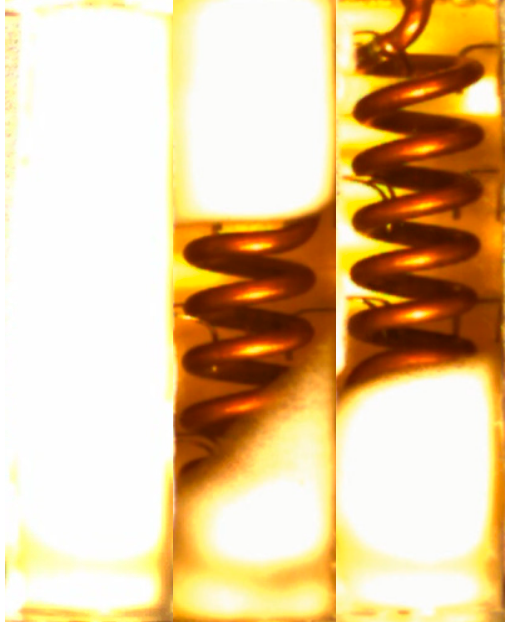
Figure 17. Melting front images for different geometry of storage units but for the same process time equal to 30 min and the same constant wall temperature condition ( Ts = 34 °C): at left for annular TES, at the middle for shell-and-coil TES with coil position at the bottom of the tank, at the right for shell-and-coil TES with coil position at upper of the tank .